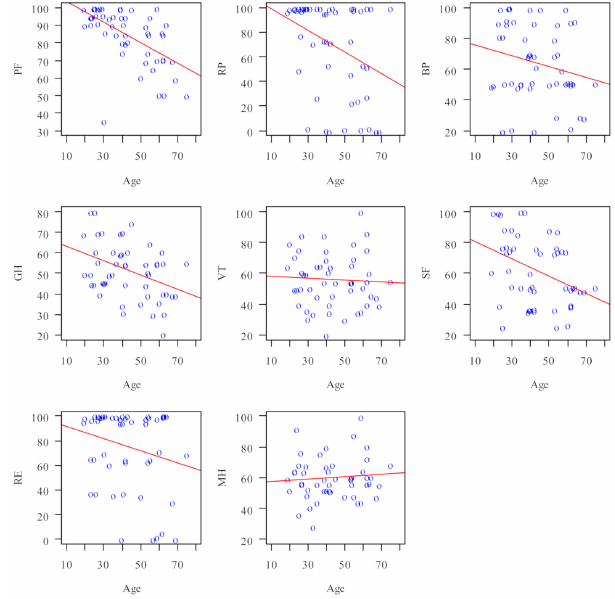
Figure 2. SF-36 domains and age correlation (age in years). Table 2. SF-36 domains and age